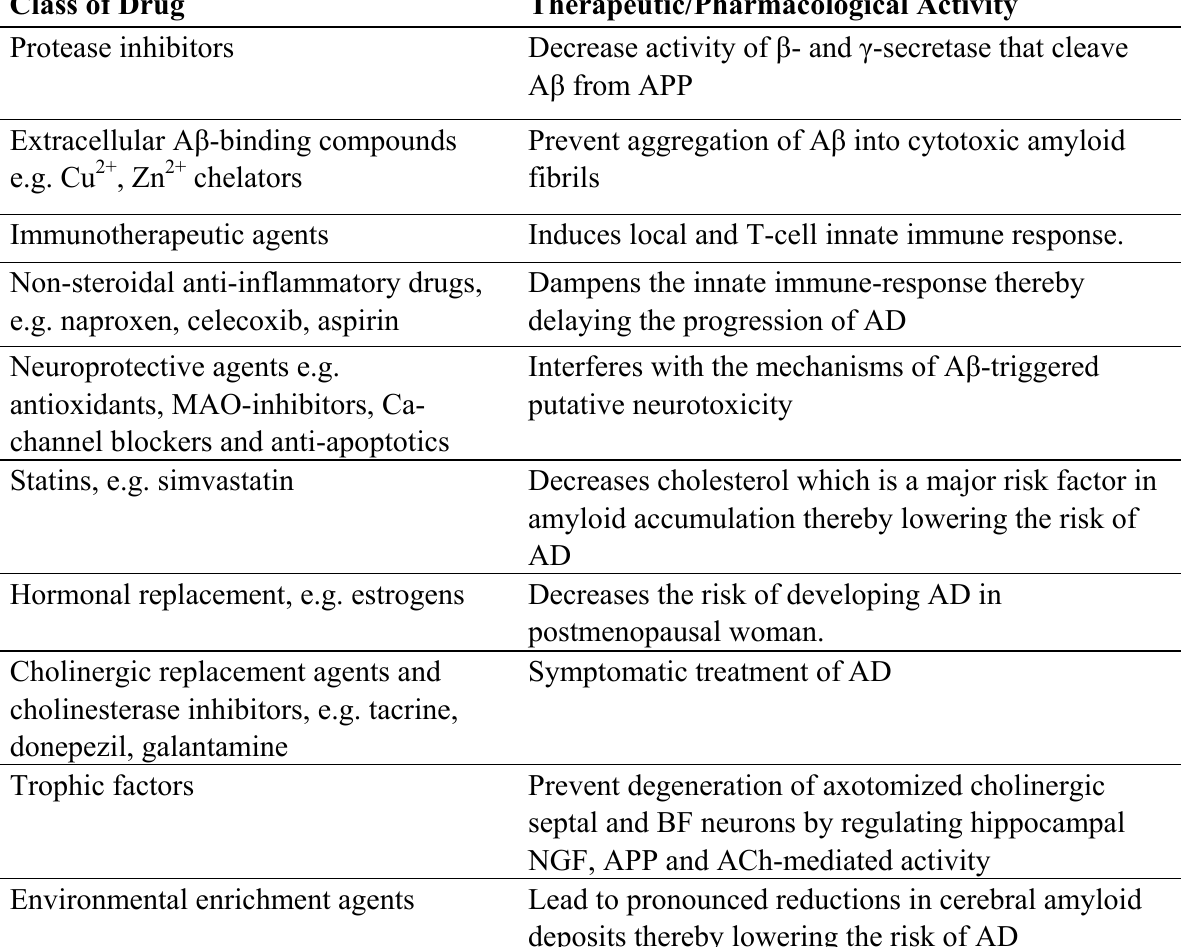
Table 1. Neuroactive classes that are currently being investigated for the treatment of Alzheimer’s